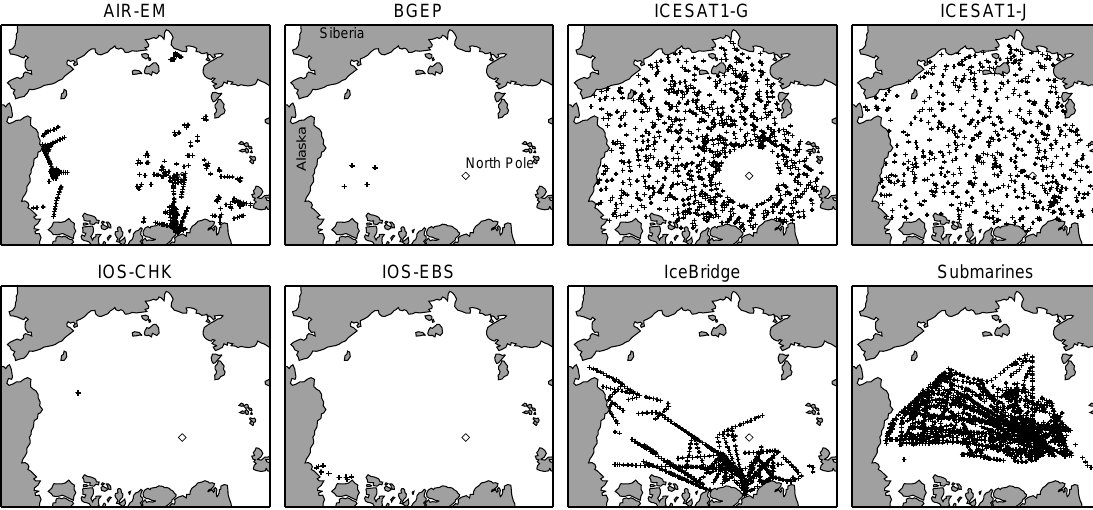
Figure 1. Locations of the observations from different data sources.